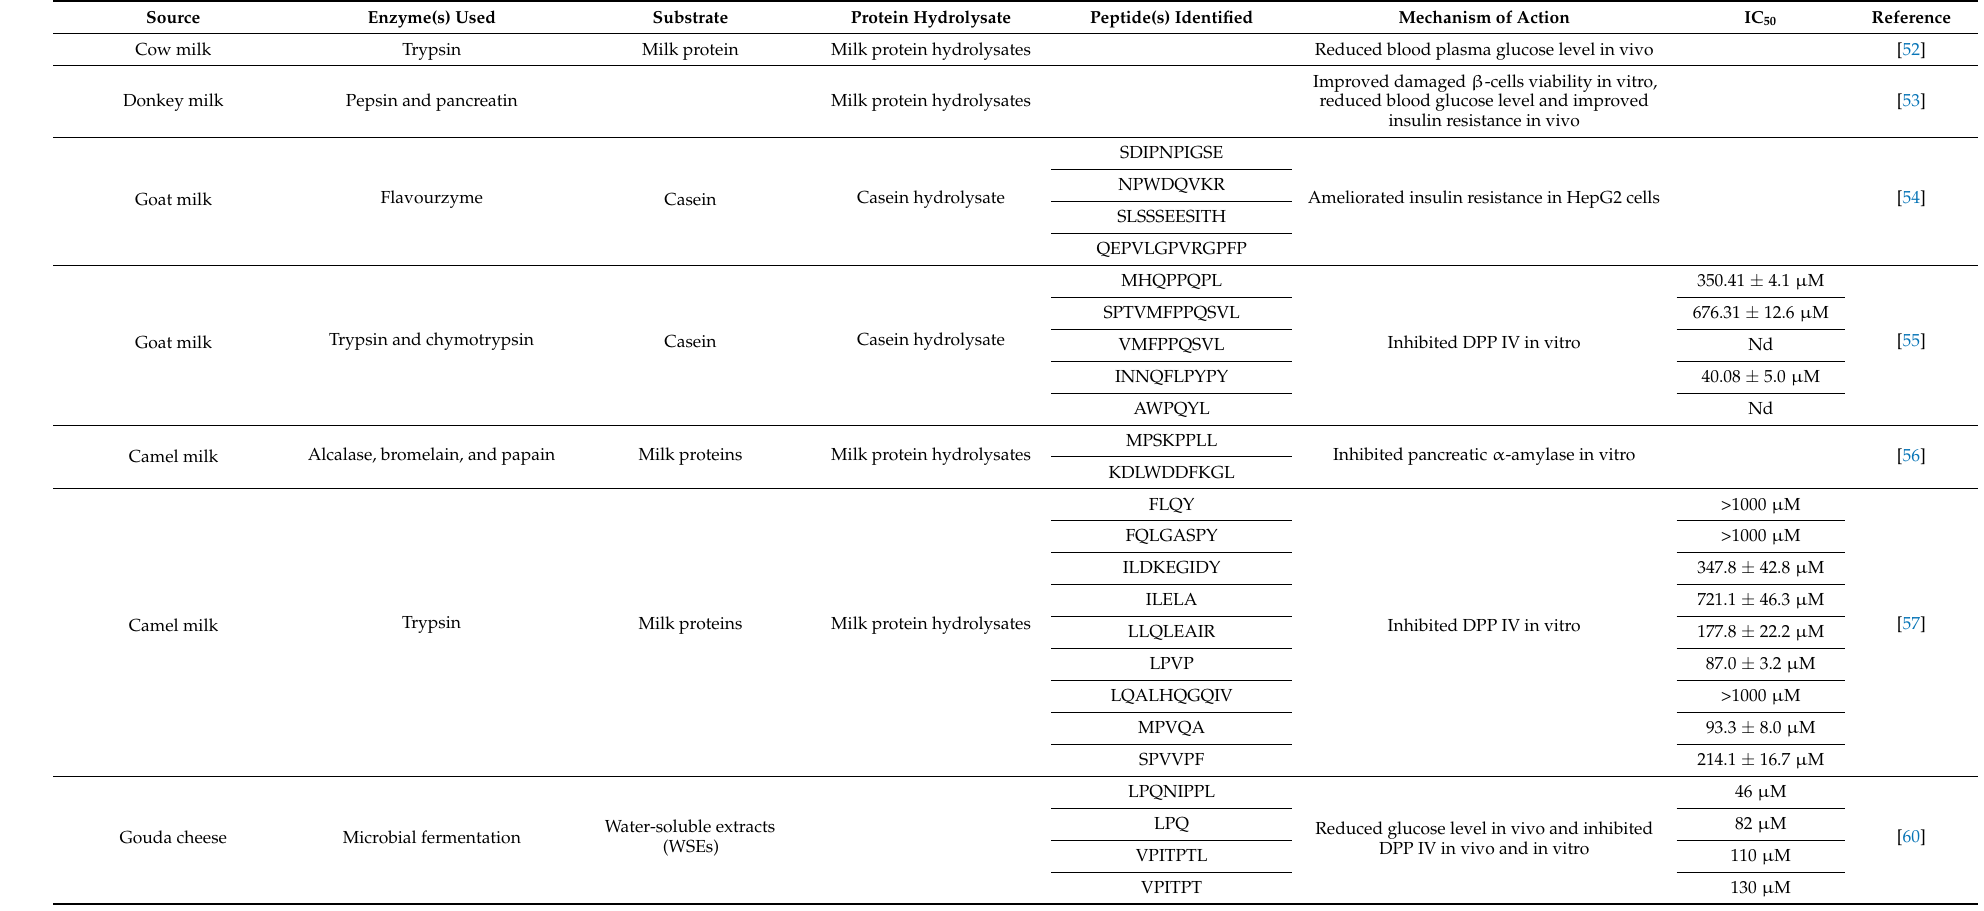
Table 1. Antidiabetic action of peptides and protein hydrolysates identified from animal food